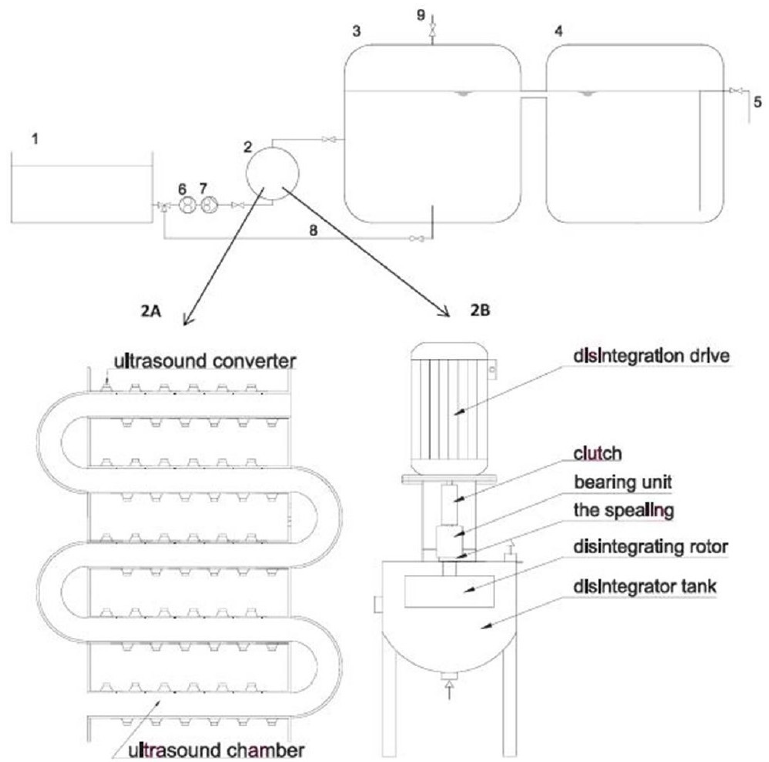
Figure 15. ABP scheme: 1-SPT, 2-cavitation-based pretreatment unit, 2A-US apparatus, 2B-HCP device, 3-MFT, 4-PFT, 5-digestate, 6-shredder, 7-pump, 8-digestate recirculation, 9-biogas outlet. Reprinted from Energy for Sustainable Development, 49, 21–26. Copyright (2019), with permission from Elsevier.